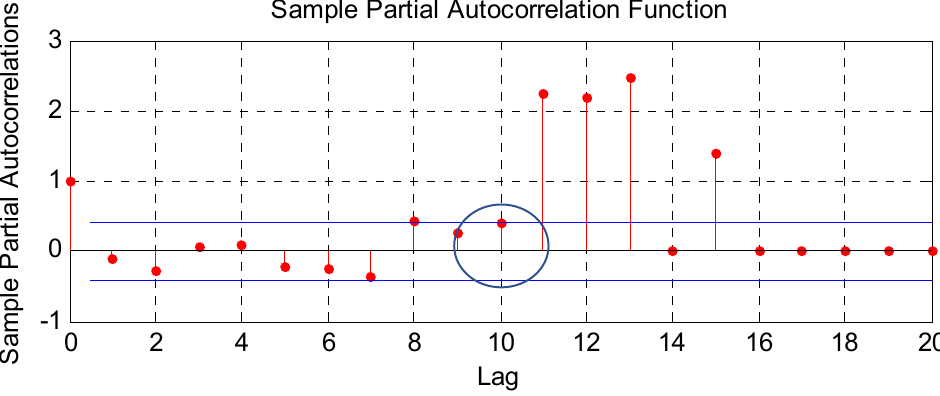
Number of observations is T = 24, so the order of AR process is ρ Partial autocorrelation function of the previous series is shown in Figure 2.